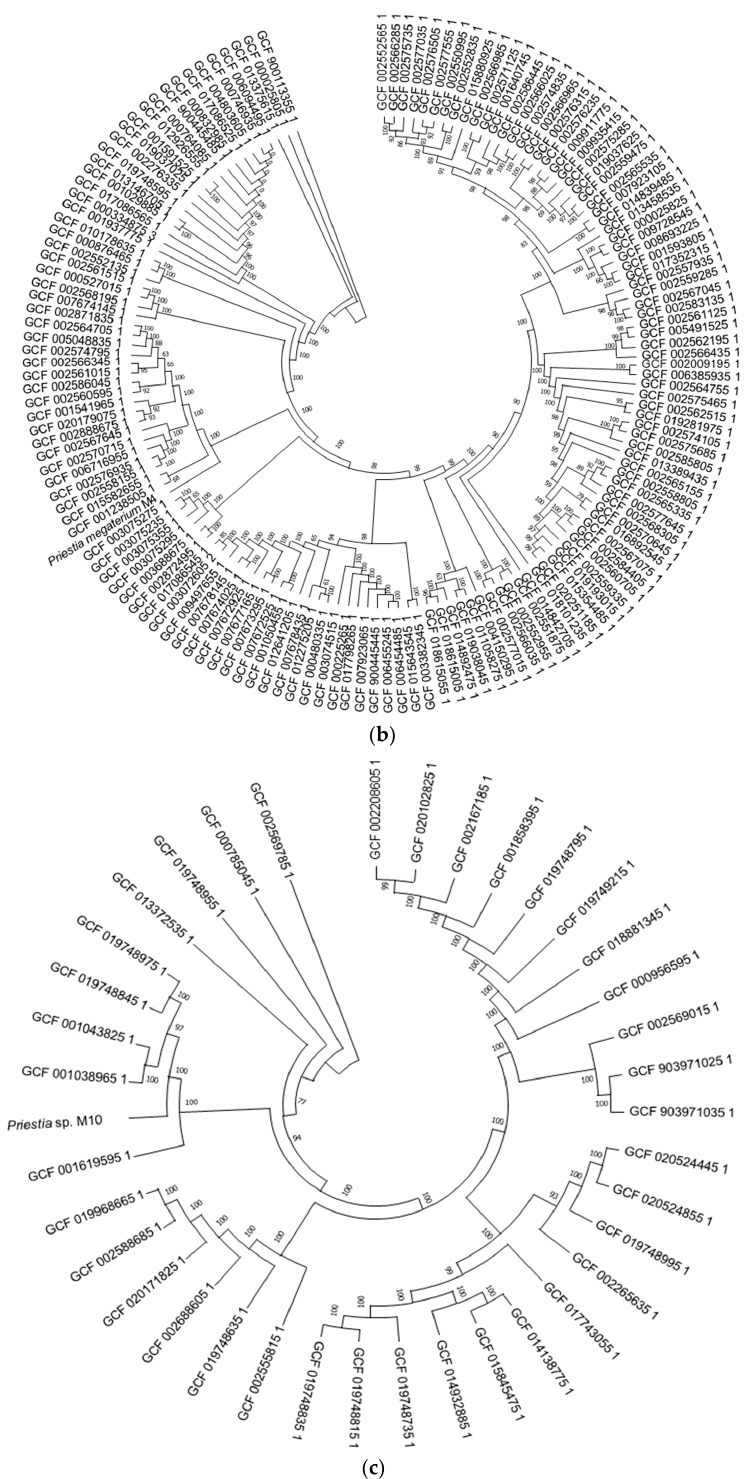
Figure 1. Core-genome maximum-likelihood phylogeny of Lactococcus lactis subsp. lactis ( a ), Priestia megaterium ( b ), and Priestia aryabhattai ( c ) strain from NCBI (RefSeq Database, https://www.ncbi.nlm.nih.gov/refseq/ (accessed on 9 January 2022)) and Lactococcus lactis A12, Priestia megaterium M4, and Priestia sp. M10, respectively. A core-genome phylogenetic representation using IQ-Tree. The tree was built from core genes identified by Roary per each strain. The log-likelihood score for the consensus tree was constructed from 1000 bootstrap.